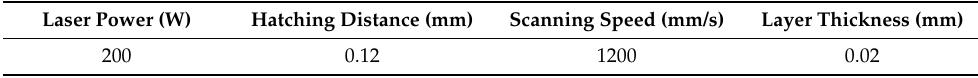
Table 3. Composition of the mixture powder (wt.%) and relative density (%) of different samples.